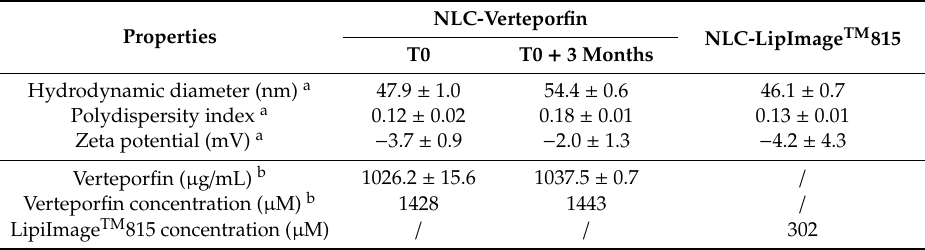
Table 1. Physico-chemical and encapsulation properties of nanostructured lipid carriers (NLC).